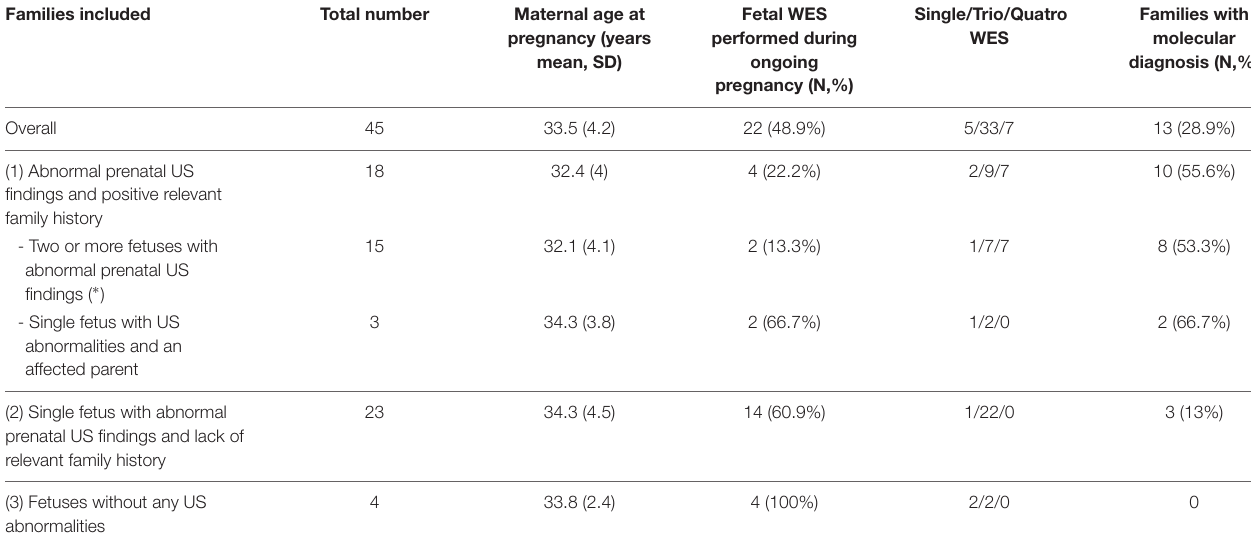
TABLE 1 | Characteristics of 45 fetal WES families included in the presented study, type of WES and rate of molecular diagnosis. Families